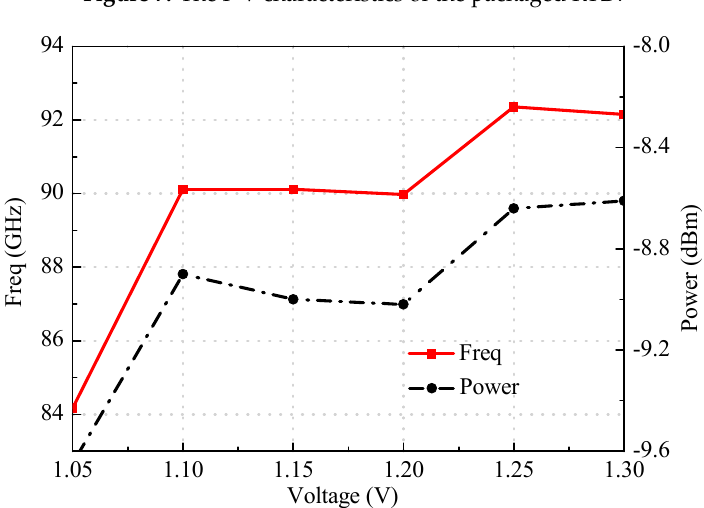
Figure 8. Measured voltage-dependent frequency and output power of the RTD.